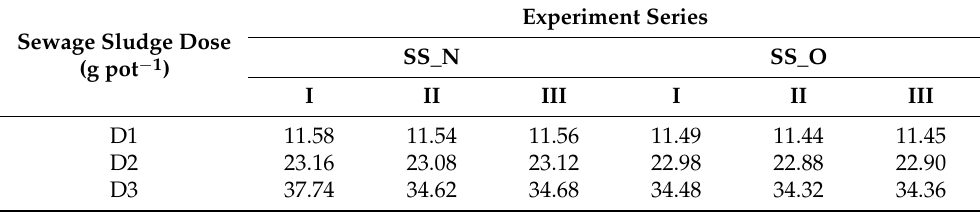
Table 2. Doses of sewage sludge dry matter per pot in each experiment series. Sewage Sludge